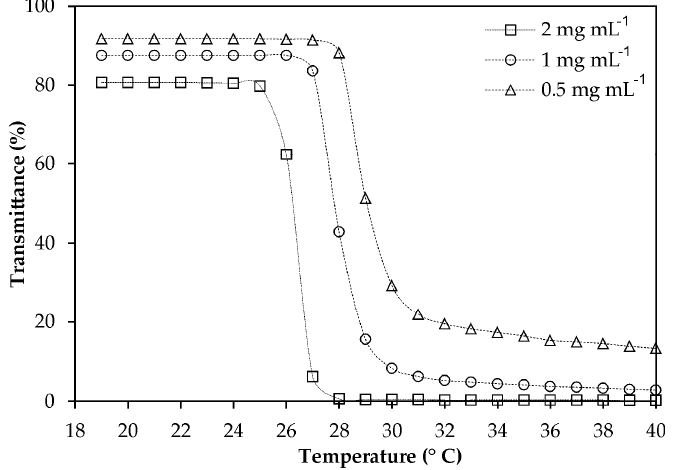
Figure 9. Effect of the concentration on the LCST of the PNVCL- b -PCL (1) block copolymer micelles. As expected, the LCST of the PNVCL- b -PCL (1) block copolymer micelles increased from 26.4